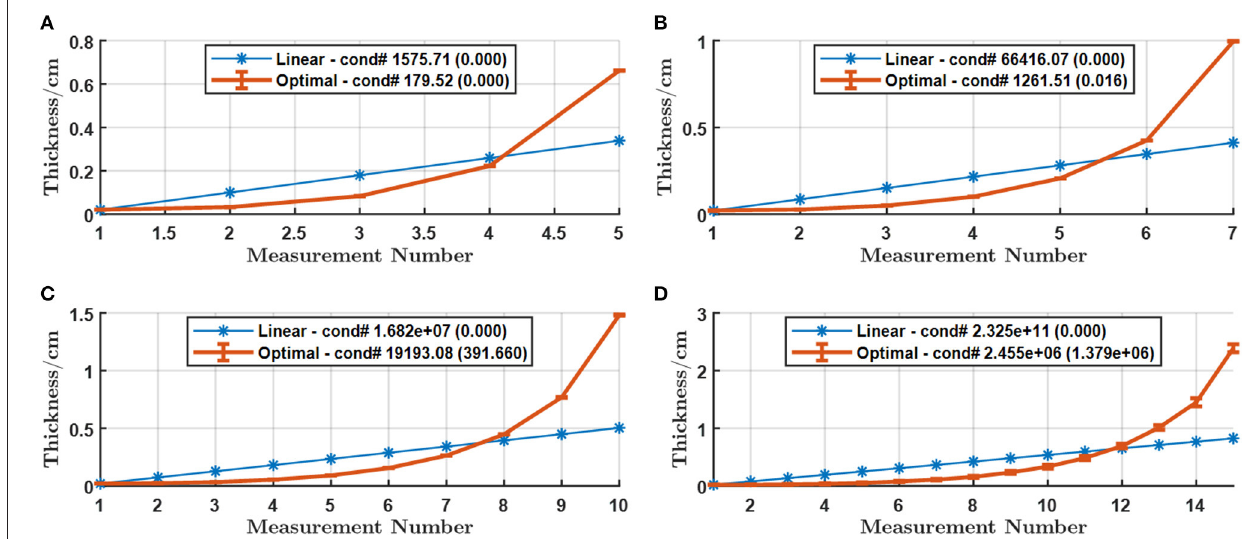
5 (B) M 7 (C) M 10 and (D) M 15 measurements with Cu within = = = =